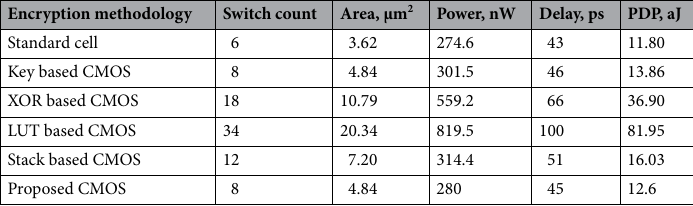
Table 11. Results comparison for AND